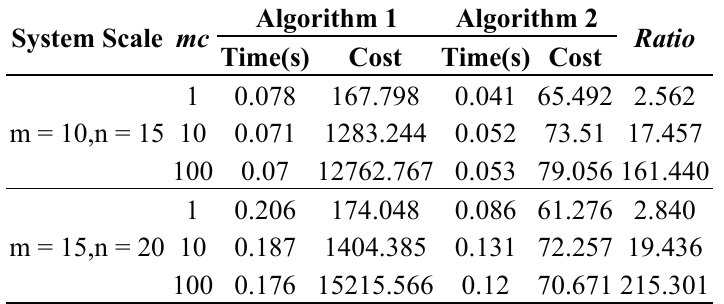
Table 1. Simulation result for the perfect test cases (N = 100, L = 3).